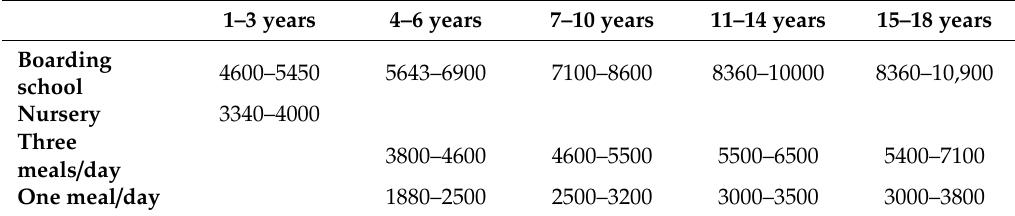
Table 2. The energy limits of school feeding